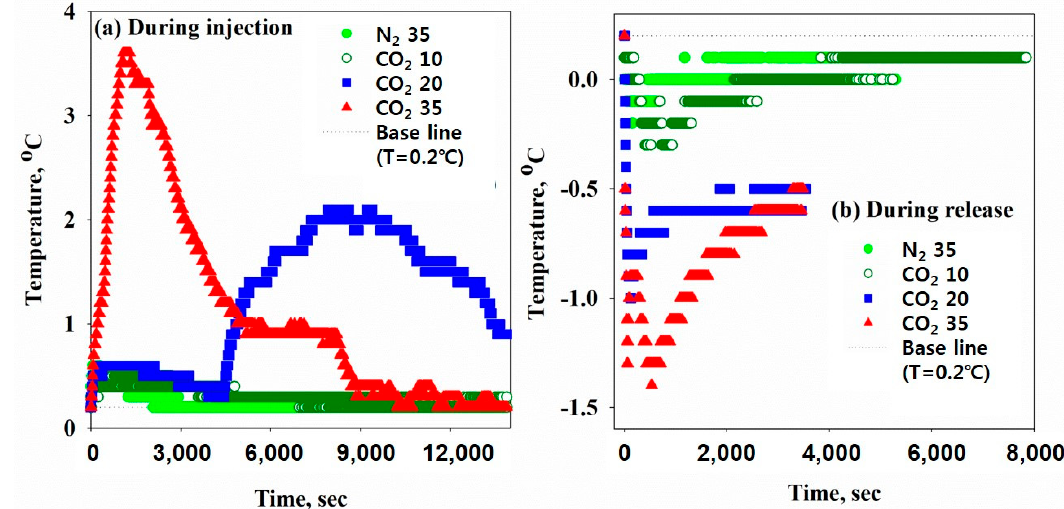
Figure 4. Temperature change of sludge samples in a reactor ( a ) during the injection of the guest gas molecules (CO 2 and N 2 ) at various applied pressures and ( b ) during the subsequent release of the pressurized gas.